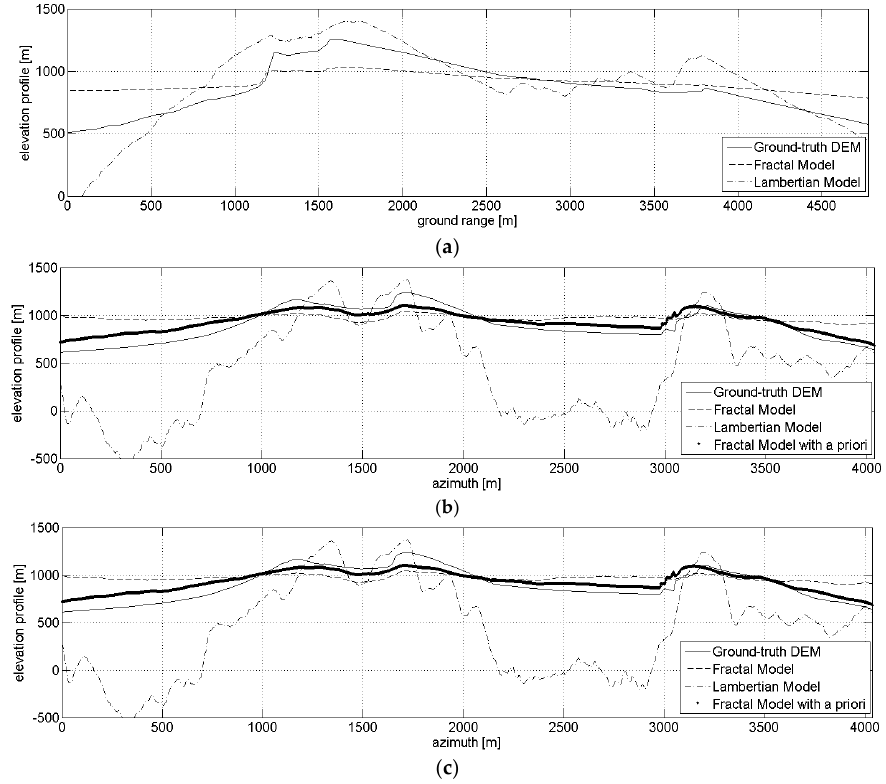
Figure 21. Reference and estimated ( a ) range and ( b , c ) azimuth profiles. The proposed methods show better agreement with the ground-truth DEM with respect the Lambertian model that provides very overestimated slopes. The a priori knowledge about starting points further increases the accuracy, especially in the azimuth cut where better performance is achieved and more features (as the Monte Somma shown in the red circle in ( c )) are correctly identified by the algorithm.